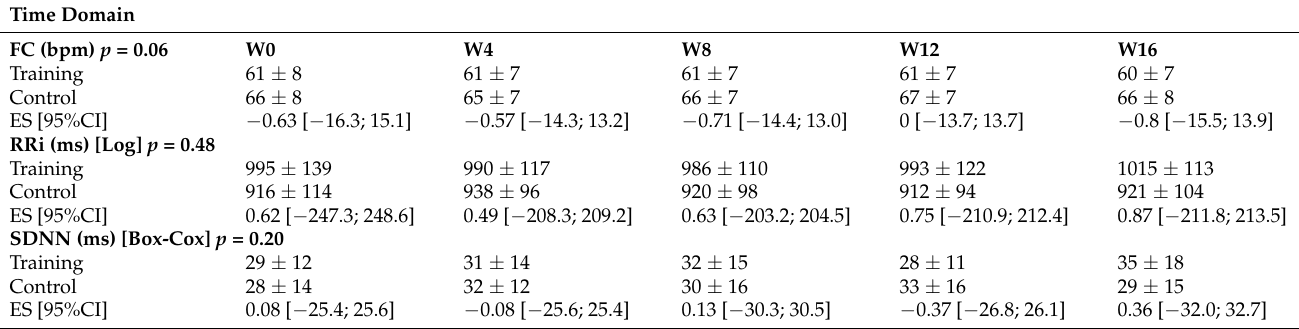
Table 5. Heart rate variability